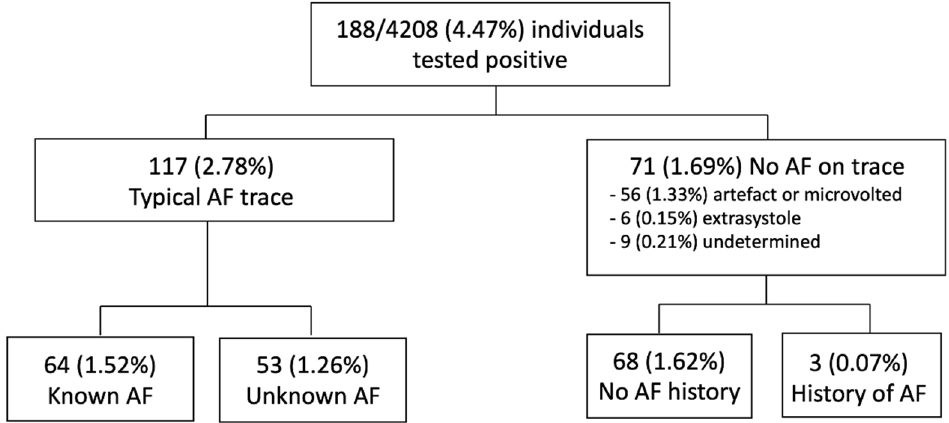
Figure 4. Flow chart of participants in the study